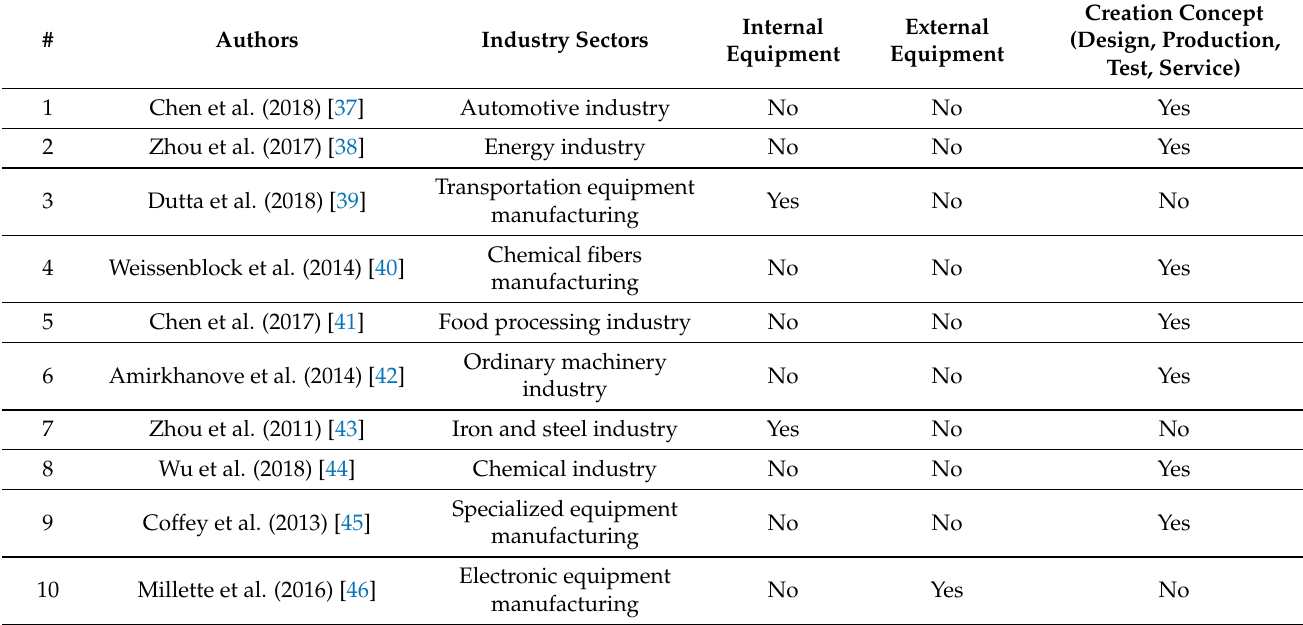
Table 1. A taxonomy of smart manufacturing